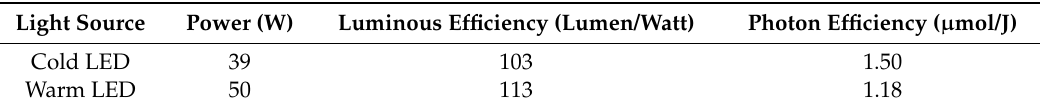
Table 1. Efficiency of LED sources.